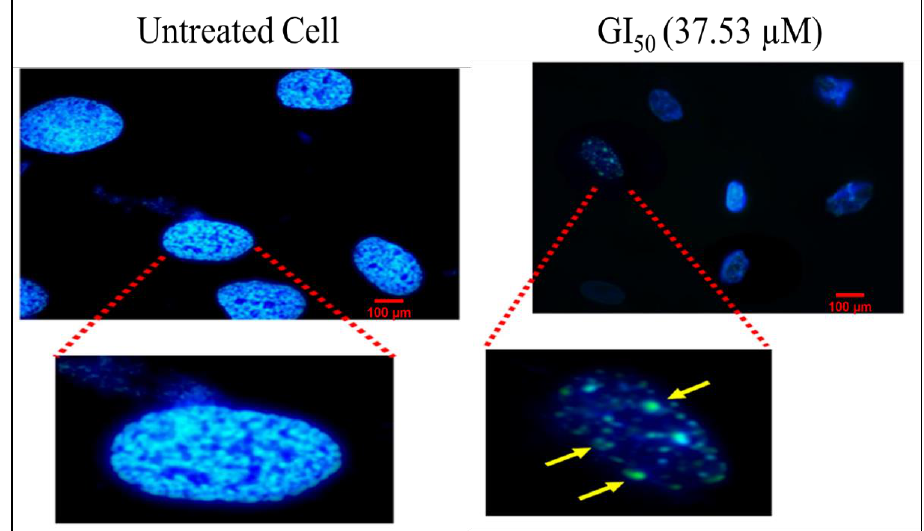
Figure 10. Fluorescence micrographs of Hoechst-stained MG-63 cells treated with BDCe fraction from O. bracteata for 24 h. Arrows show nuclear condensation/fragmentation and formation of apoptotic bodies at a magnification (100 × ) objective lens using oil immersion.